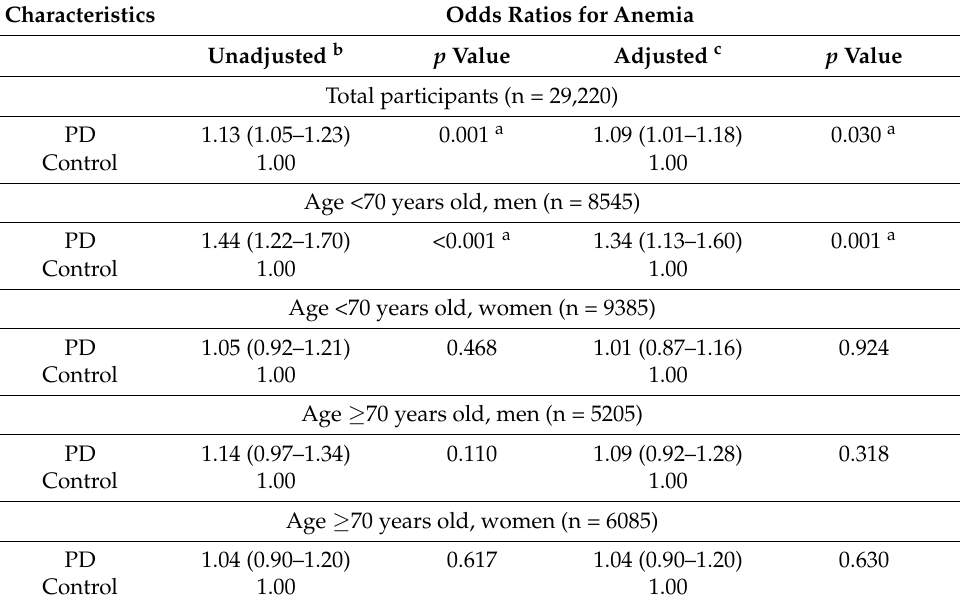
Table 2. Unadjusted and adjusted odds ratios (95% confidence intervals) for anemia in the Parkinson’s disease and control groups according to age and